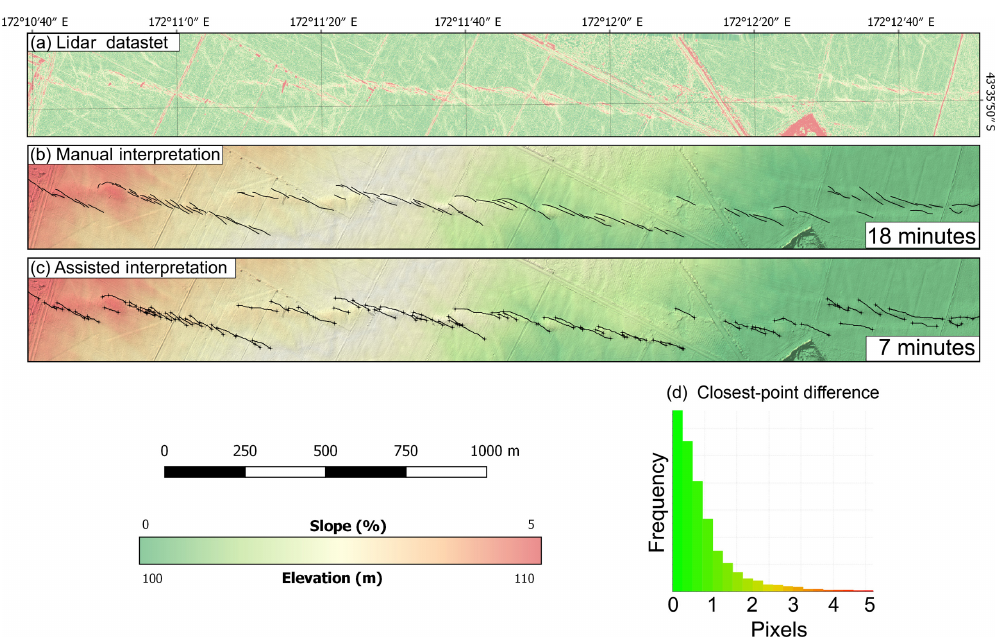
Figure 4. Slope map derived from the Greendale lidar dataset showing surface ruptures of a section of the Greendale Fault, New Zealand collected shortly after the M w 7.1 Darfield earthquake (a) . Traces interpreted manually (b) and using the GeoTrace implementation of our least-cost-path method (c) are essentially equivalent (d) . Control points for the assisted interpretation are shown as small crosses. Background for (b) and (c) shows the